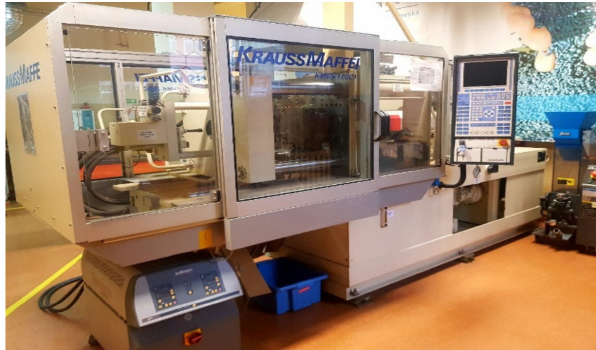
Figure 7. Krauss-Maffei injection molding machine.